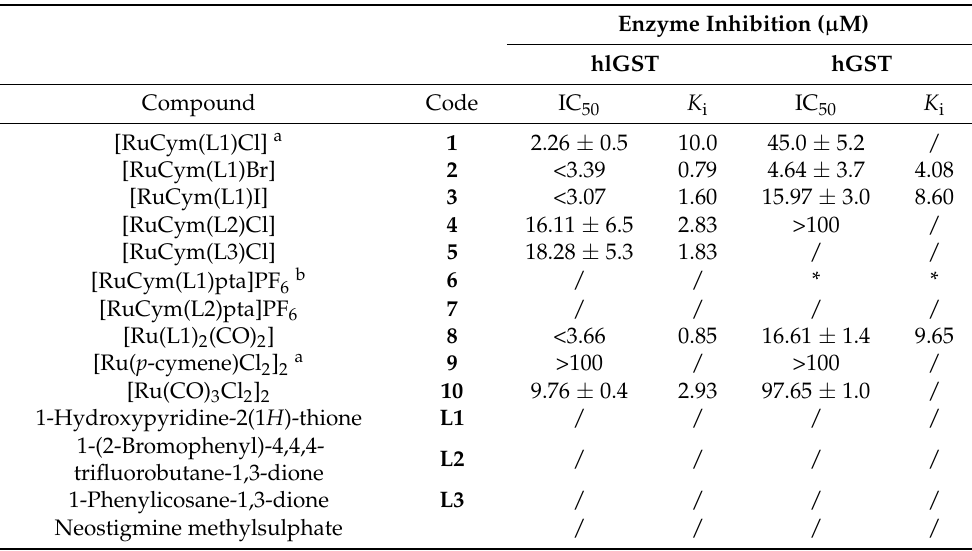
Table 3. Inhibition of horse liver (hlGST) and human placenta glutathione S-transferase (hGST) by the ruthenium compounds 1 – 10 and the free ligands L1 – L3